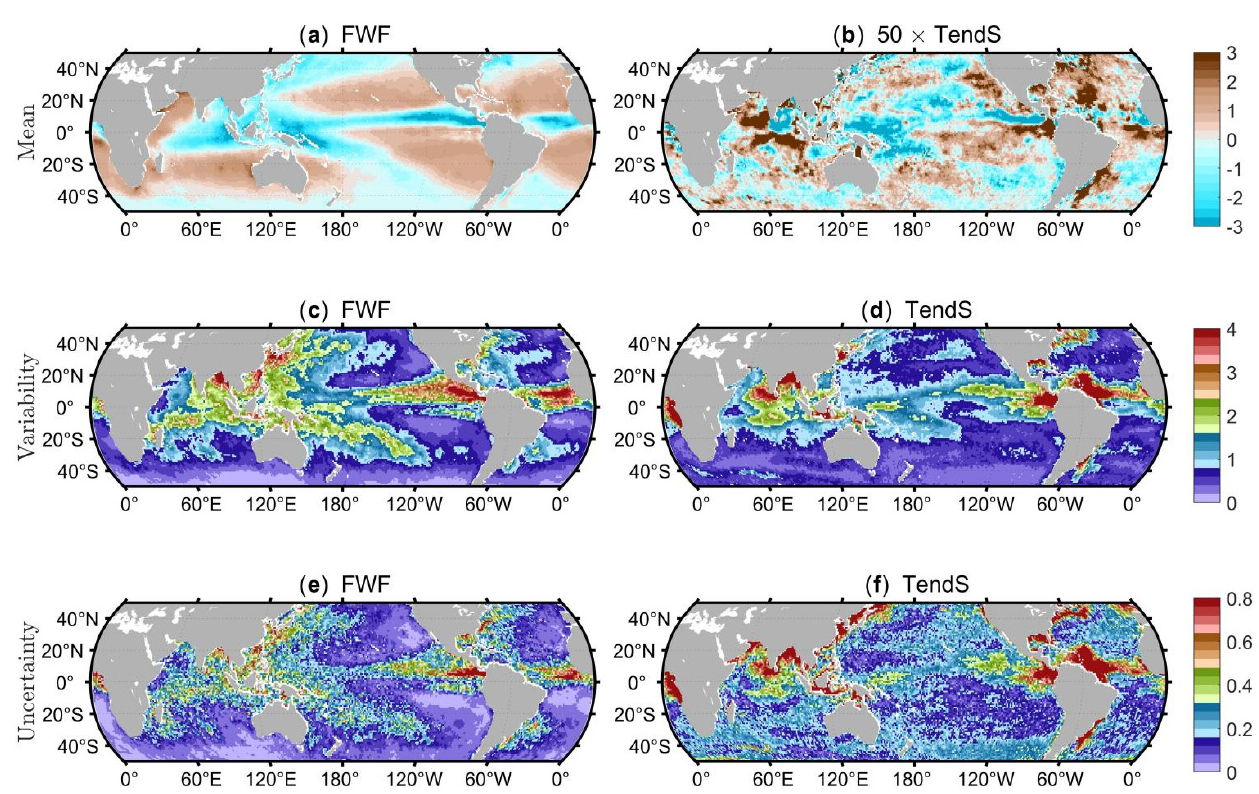
Figure 4. Time-averaged ( a ) FWF and ( b ) SSS tendency during 2012–2017. Variability of ( c ) ensemble median FWF and ( d ) ensemble median SSS tendency, and uncertainty of ( e ) FWF and ( f ) SSS tendency. The units for FWF and SSS tendency are g/kg/year.